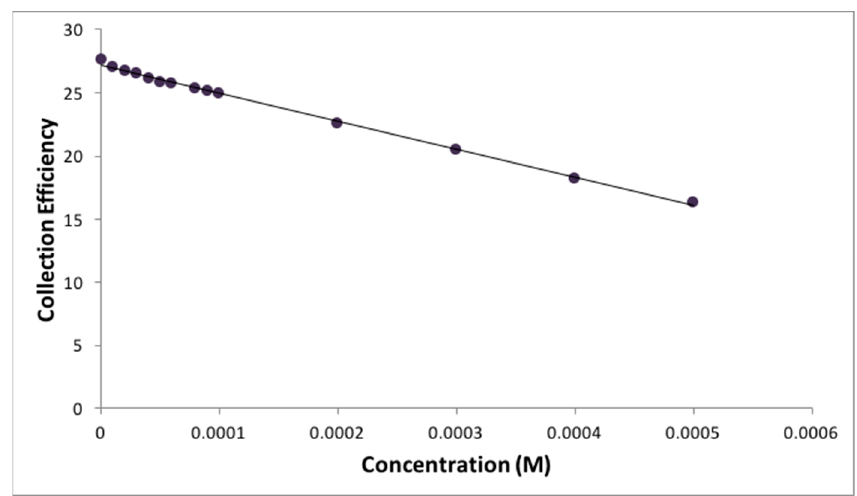
Figure 12 Collection efficiency for quercetin.